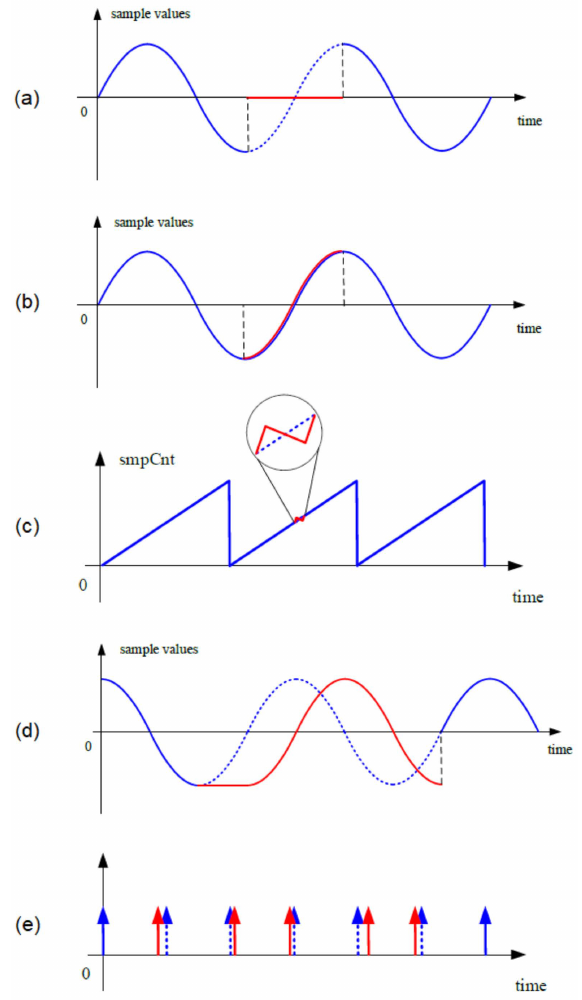
Figure 3. The RTDS Simulator’s stream manipulation options for IEC 61850 Sampled